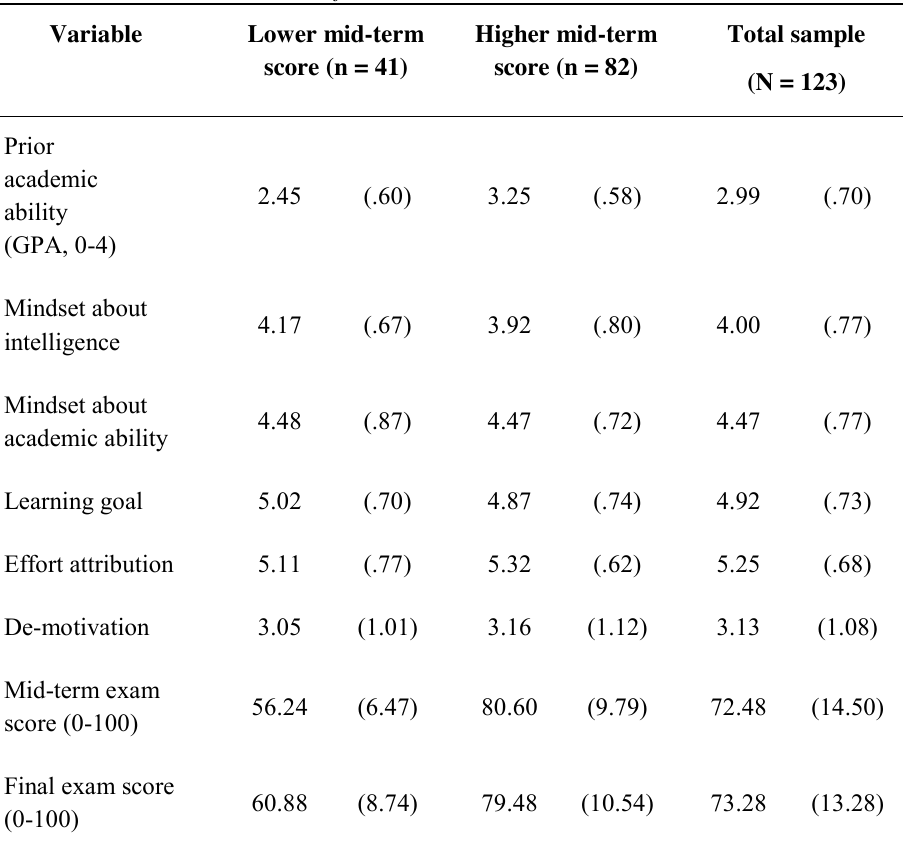
Mean and standard deviations for the main